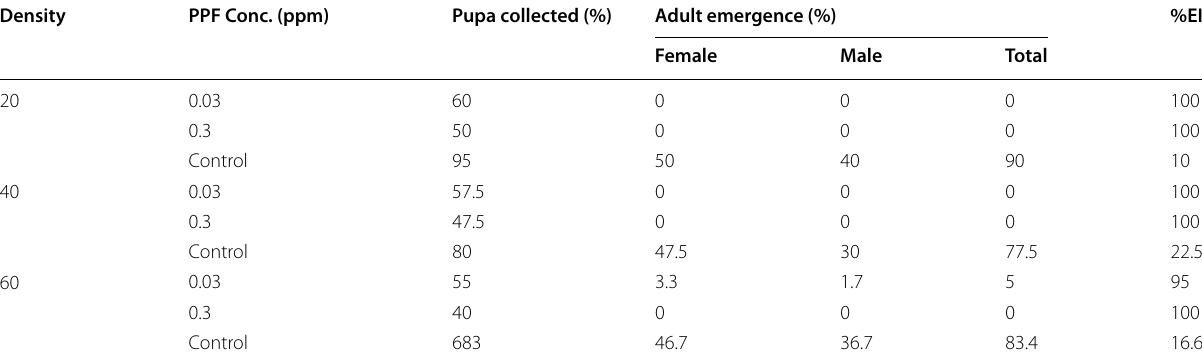
EI% is Emergence inhibition